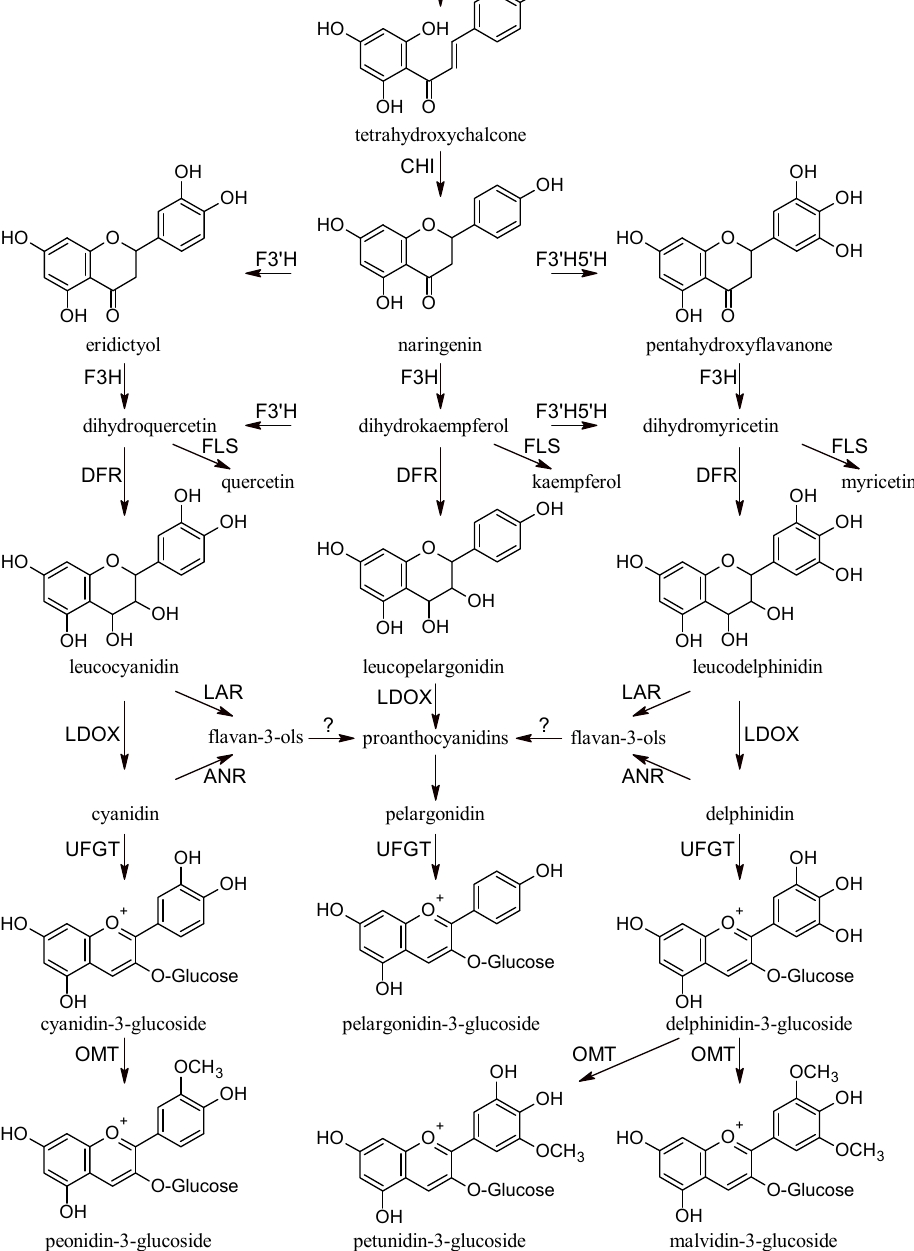
Figure 2. Flavonoid pathway. CHS, chalcone synthase; CHI, chalcone isomerase; F3'H, flavonoid-3'-hydroxylase; F3'5'H, flavonoid-3',5'-hydroxylase; F3H, flavanone-3-hydroxylases; FLS, flavonol synthase; DFR, dihydroflavonol reductase; LAR, leucoanthocyanidin reductase; LDOX, leucoanthocyanidin dioxigenase; ANR, anthocyanidin reductase; UFGT, UDP-glucose:flavonoid 3- O -glucosyl transferase; OMT, O -methyltransferase.